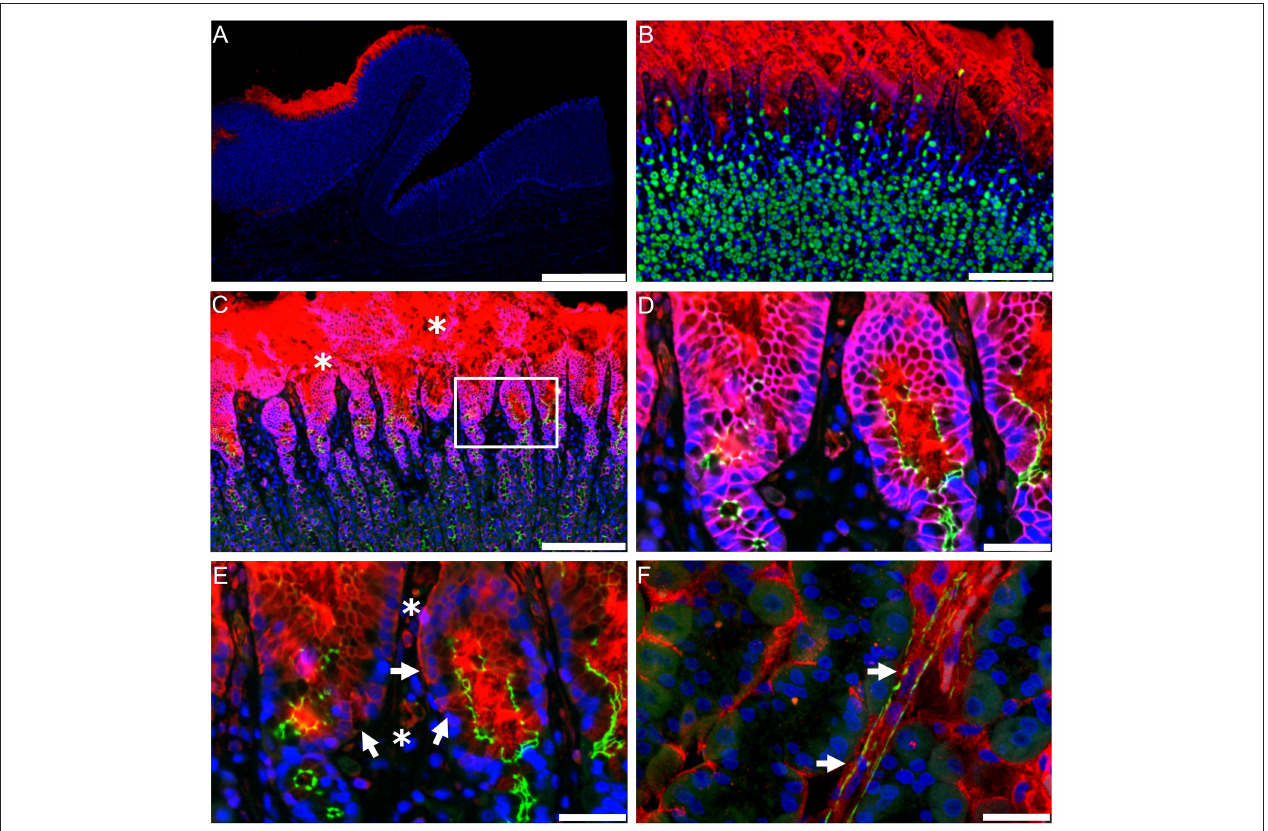
FIGURE 13 | Absorption and localization of semaglutide in dog gastric mucosa. (A) Local 3F15 (semaglutide) immunofluorescence reactivity (red) under the tablet. Nuclei counterstained with 4 ′ ,6-diamidino-2-phenylindole (DAPI; blue). Scale bar, 2mm. (B) 3F15 reactivity (red) restricted to the neck region. The bulk of H + /K + ATPase (green)–positive parietal cells reside in deeper layers, but a few scattered parietal cells can be found in the neck region exposed to luminal semaglutide. Scale bar, 200 µ m. (C) 3F15 (red), β -catenin (purple), ZO1 (green), and DAPI (blue). Sloughing of the uppermost region of the epithelium is marked by white asterisks; semaglutide is also detected in deeper, intact layers (white box). Scale bar, 200 µ m. (D) Higher magnification of the boxed area in (C) . Intact tight junctions labeled with apical ZO1 (green) in direct contact with luminal semaglutide. Scale bar, 40 µ m. (E) Same region as (D) without β -catenin. Intracellular 3F15 reactivity (red) is observed in mucosal cells (marked by white arrows). 3F15 also detects semaglutide in capillaries under the epithelium (marked by white asterisks). Scale bar, 40 µ m. (F) Maximum projection image from a 63 × confocal 11- µ m z stack, showing semaglutide (red) associated with a blood vessel (marked by white arrows) labeled with smooth muscle actin (green). Scale bar, 40 µ m. From Buckley et al. ( 262). Reprinted with permission from the American Association for the Advancement of Science